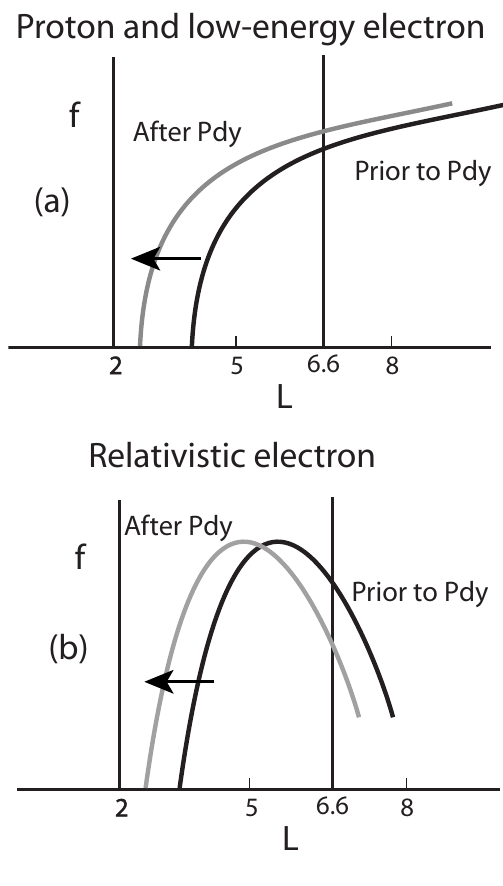
Fig. 3. Schematic radial profiles of phase space density at con- stant µ and J inferred from the particles’ response to the dynamic pressure enhancements. (a) For protons and low-energy electrons; (b) For relativistic electrons. The black lines represent the profile prior to the pressure enhancements. The grey lines represent the profile after the onset of the pressure